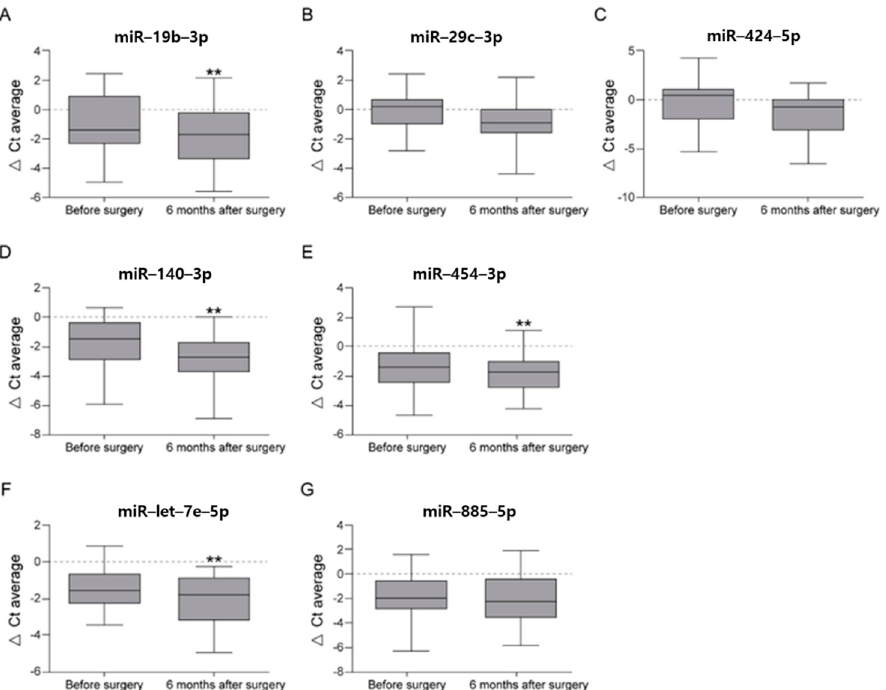
Figure 3. Box plot showing the interquartile range and median values of the expression levels of miR-19b-3p ( A ), miR-29c-3p ( B ), miR-424-5p ( C ), miR-140-3p ( D ), miR-454-3p ( E ), miR-let-7e-5p ( F ), and miR-885-5p ( G ) before surgery and 6 months after surgery at the validation stage. The values represent the relative levels normalized to the level of the reference gene, SNORD61 . ** indicates a Bonferroni-corrected p -value < 0.0071 (0.05/7) corresponding to the statistical significance.